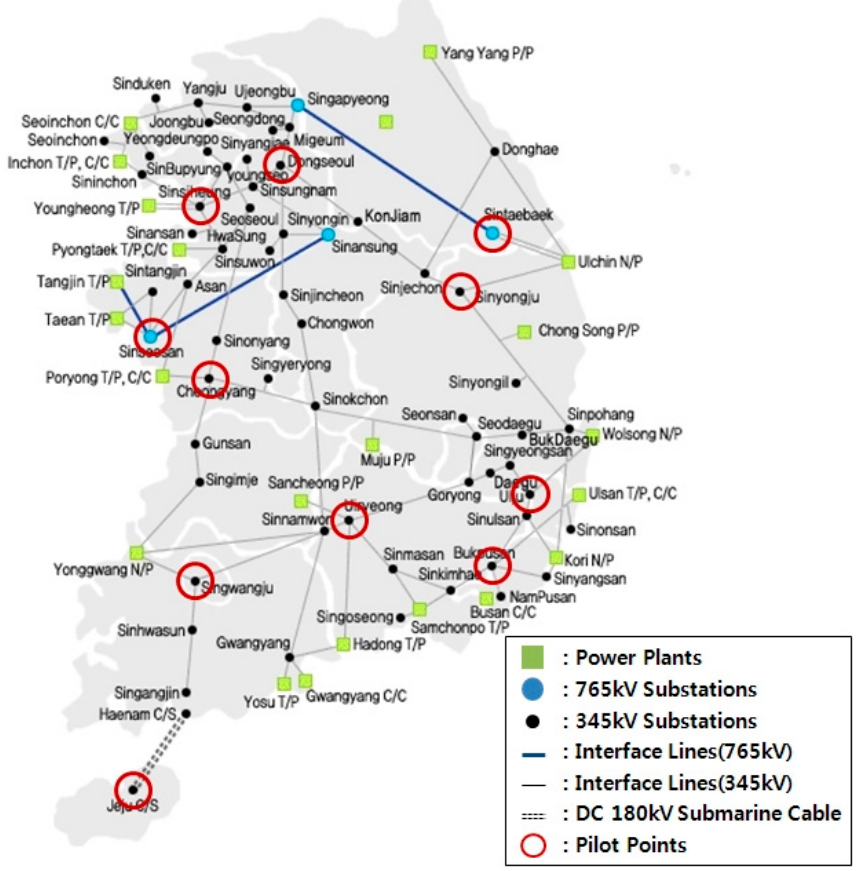
Figure 9. Map of the Korean power system. Table 2. Summary of the Korean power system.